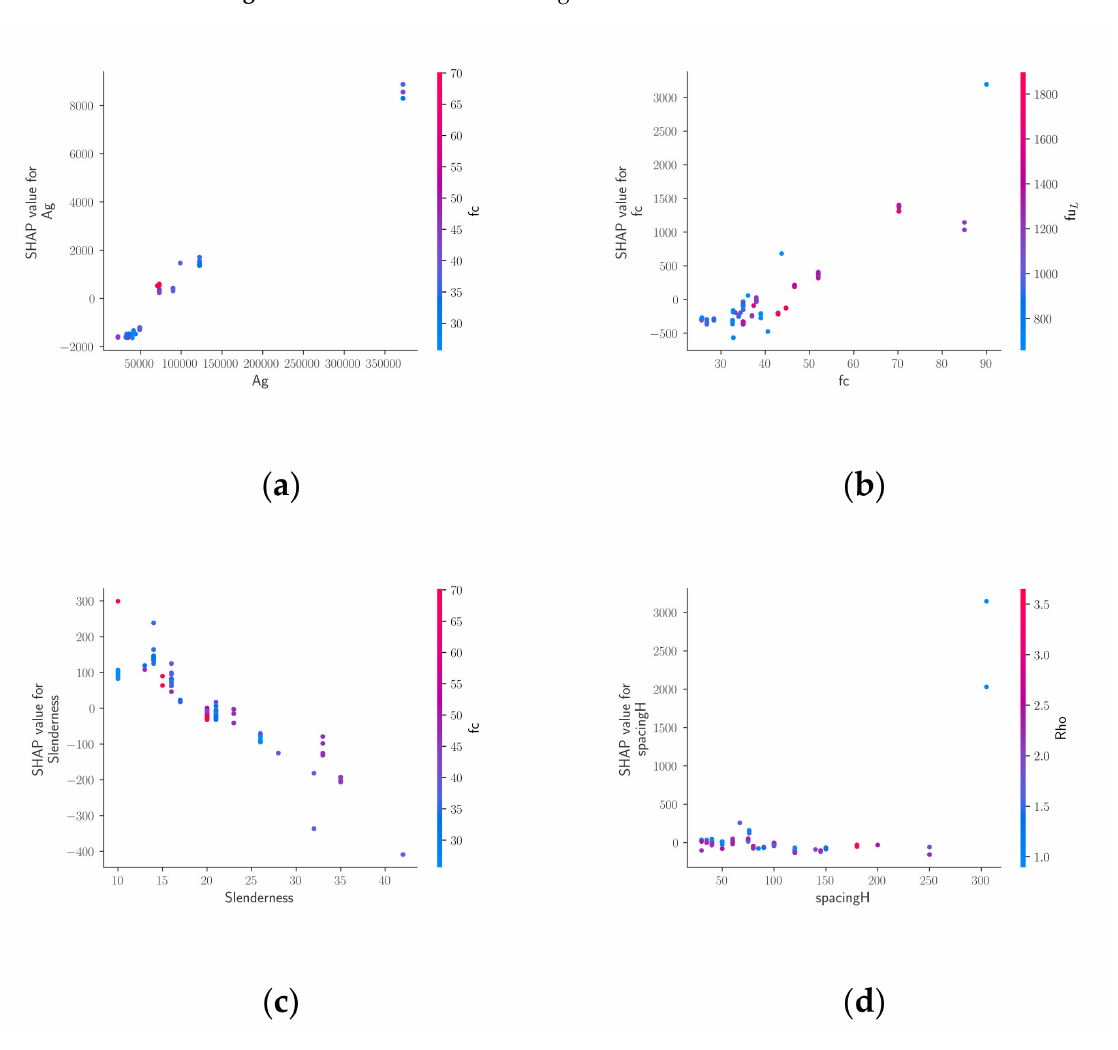
Figure 5. Feature dependence plots for the XGBoost model; ( a ) A g − f (cid:48) c ; ( b ) f (cid:48) c − f uL ; − ρ ( c ) Slenderness − f (cid:48) c ; ( d ) spacing H